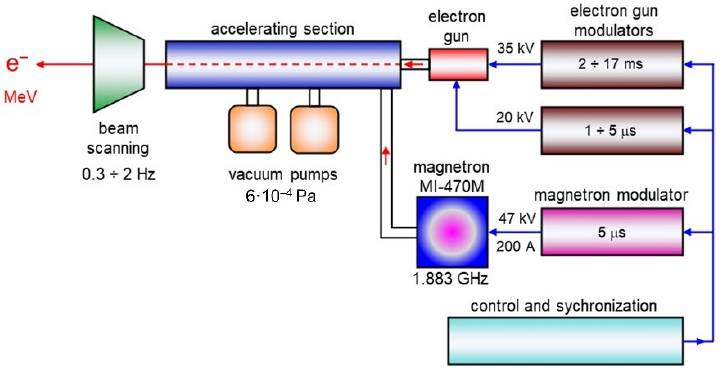
Figure 3. Scheme of the Linac ELU-6e accelerator.